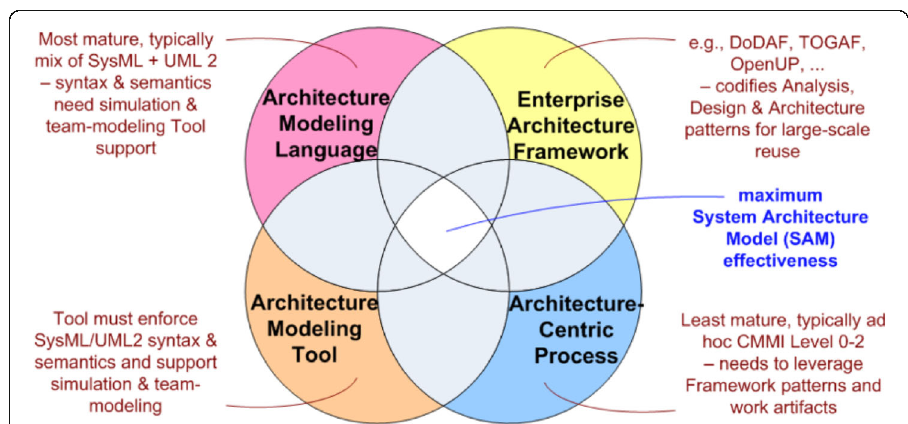
Fig. 5 MBSE (Model-Based Systems Engineering) architecture (SysML.org